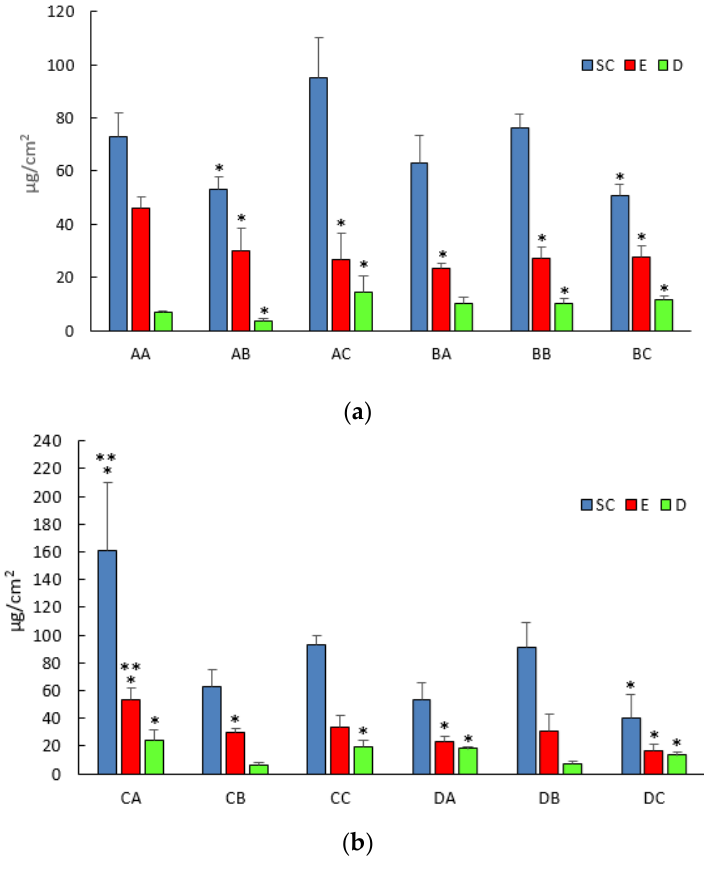
Figure 4. Idebenone skin penetration into stratum corneum (SC), epidermis (E) and dermis (D) from ( a ) formulations AA, AB, AC, BA, BB, BC and ( b ) formulations CA, CB, CC, DA, DB, DC; * statistically different compared to the value of formulation AA for the corresponding skin layer; ** statistically different compared to all other formulations for the corresponding skin layer.